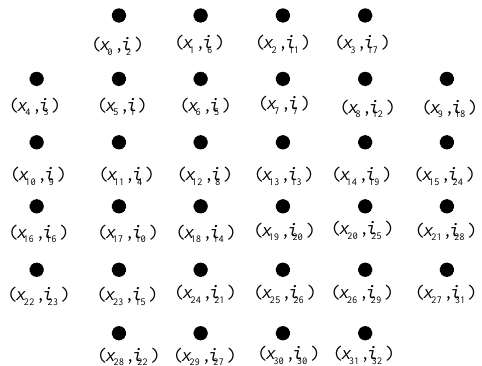
Figure A1. An example of the assignment